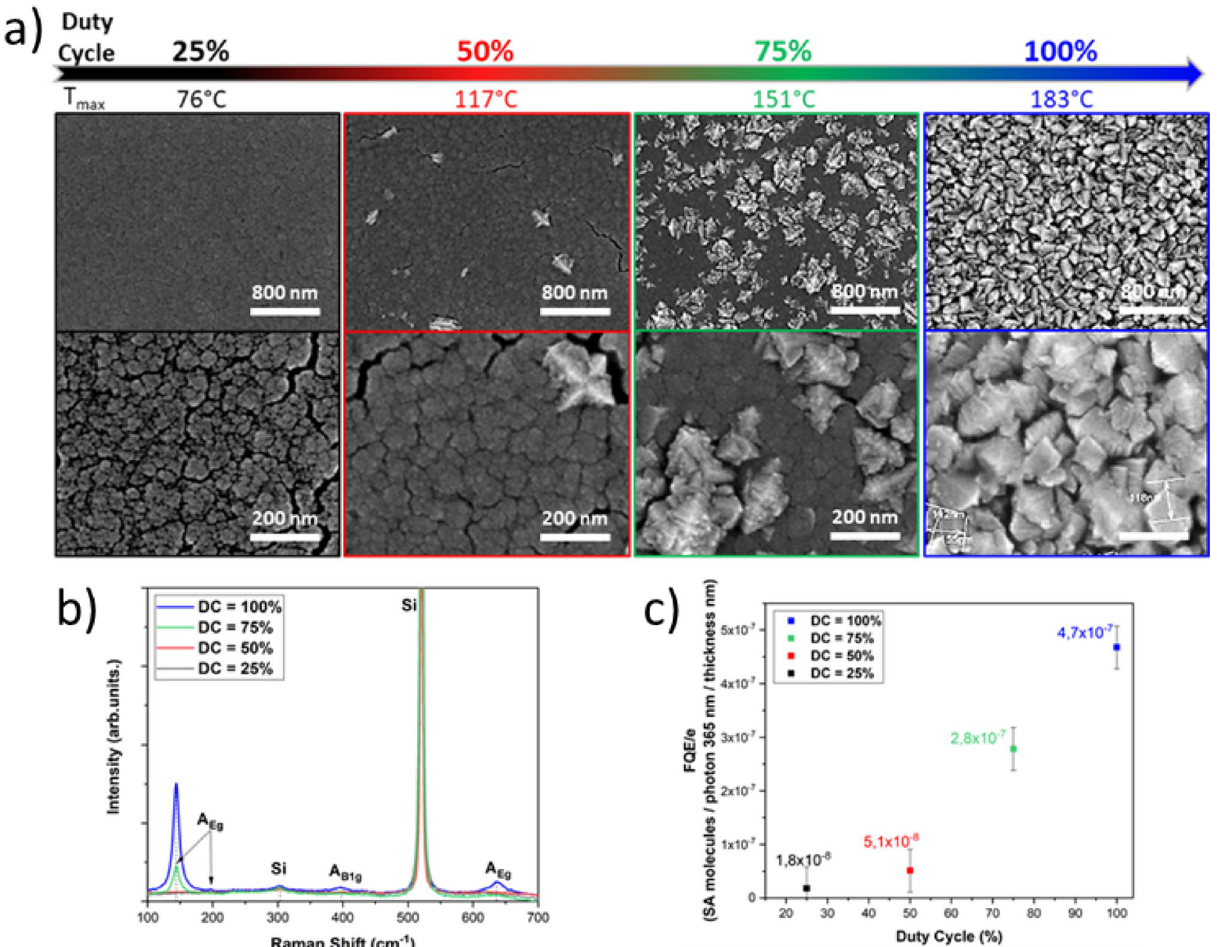
Figure 5. SEM topviews with associated T sub max ( a ) Raman scattering spectra ( b ) and Photocatalytic activity normalized to the thickness ( c ) of TiO 2 films deposited at different Duty Cycles (Power 500 W (T on ), 1 h deposition, f = 10